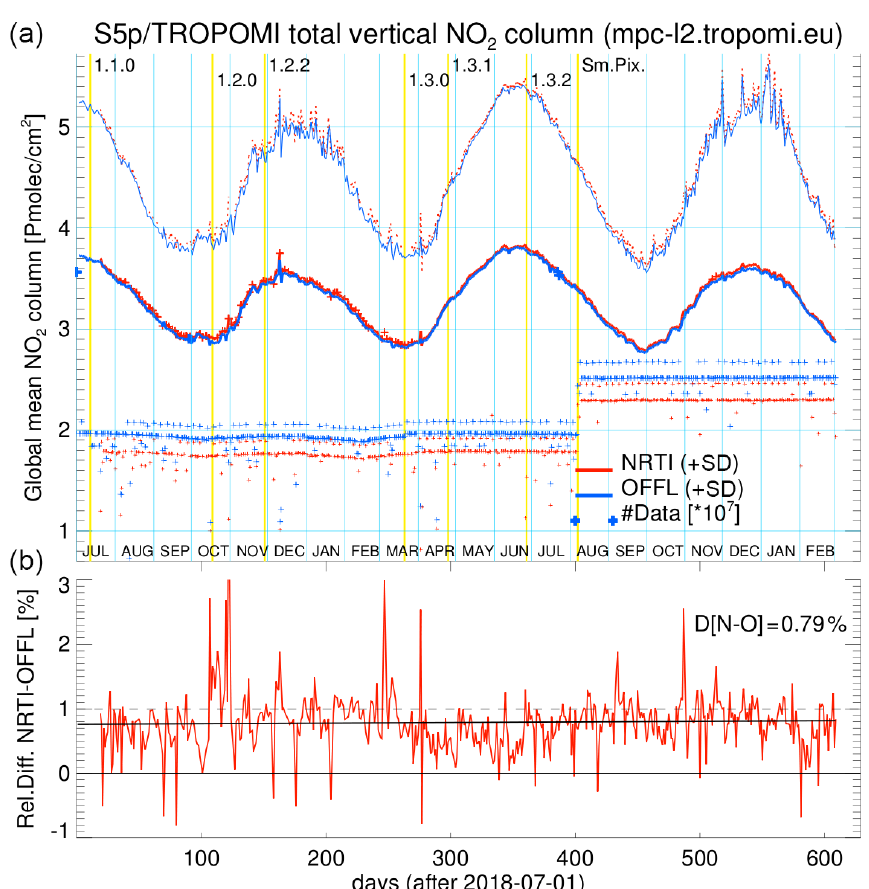
Figure 2. (a) Time series of the global means of NO 2 total column data retrieved with the NRTI (red line) and OFFL (blue line) processors, and their standard deviation, in Pmoleccm − 2 , from July 2018 till February 2020. Crosses depict the number of measurements divided by 10 7 , with the same colour code: red for NRTI, blue for OFFL. Yellow vertical lines indicate the transition dates for processor upgrades and the switch to the smaller ground pixel size. (b) Percent relative difference between NRTI and OFFL global means of total NO 2 values. The Theil–Sen linear regression line (black) is